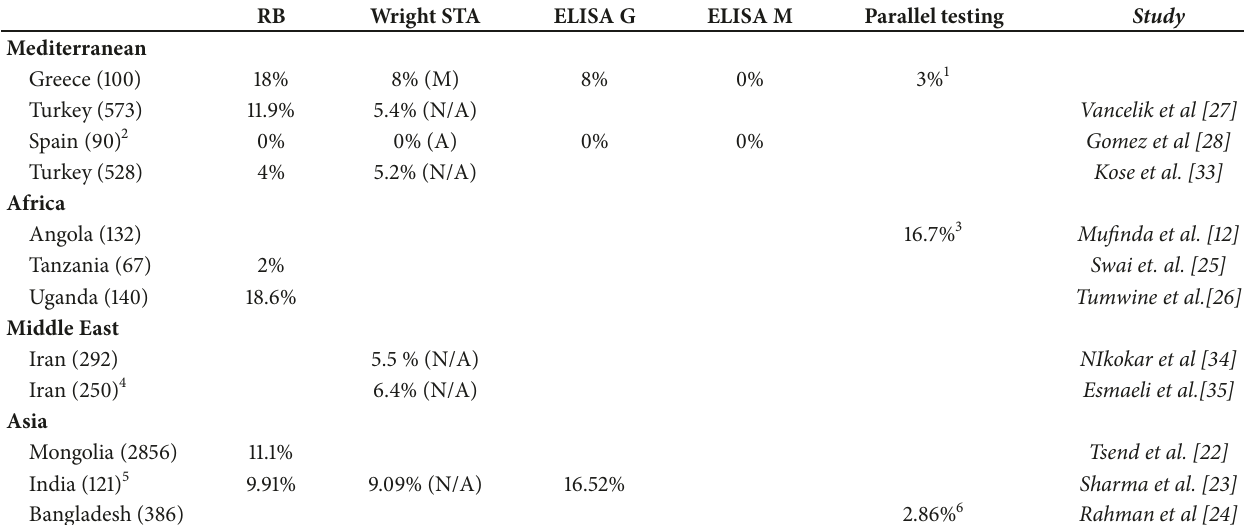
Table 3: Comparative results of seroprevalence studies in endemic